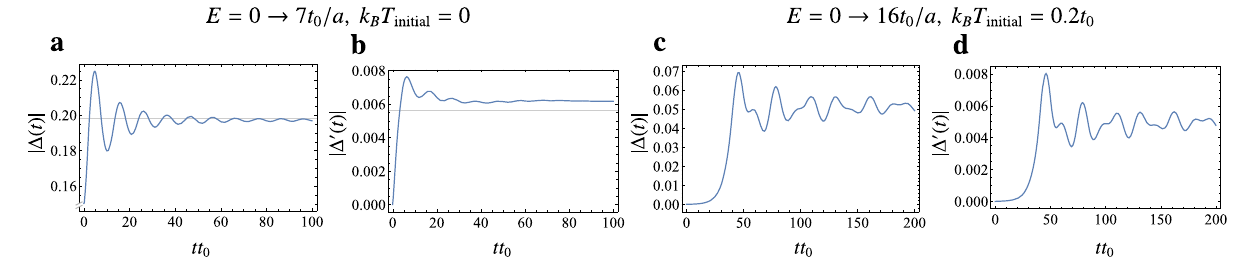
Fig. 6 Quench dynamics of the order parameters. Time evolution of ∣ Δ ∣ = ∣ 〈 c i ↑ c i + x , ↓ 〉 ∣ and j Δ 0 j ¼ jh c i " c i þ x þ y ; # ij after a sudden quench of the fi eld amplitude from E = 0 to E = 7 t 0 / a with an initial temperature k B T initial = 0 ( a , b ), or to E = 16 t 0 / a with an initial k B T initial = 0.2 t 0 ( c , d ). The latter corresponds to the case in which the superconductivity appears even when we start from an initial temperature above T c . ∣ Δ ∣ ( a , c ) represents the conventional d x 2 (cid:3) y 2 -wave component, while j Δ 0 j ( b , d ) represents the time-reversal breaking id xy -wave component. Horizontal lines indicate the equilibrium value at the effective temperature. The driving frequency is set to ω = 10.5 t 0 = 0.88 U with t 0 being the bare